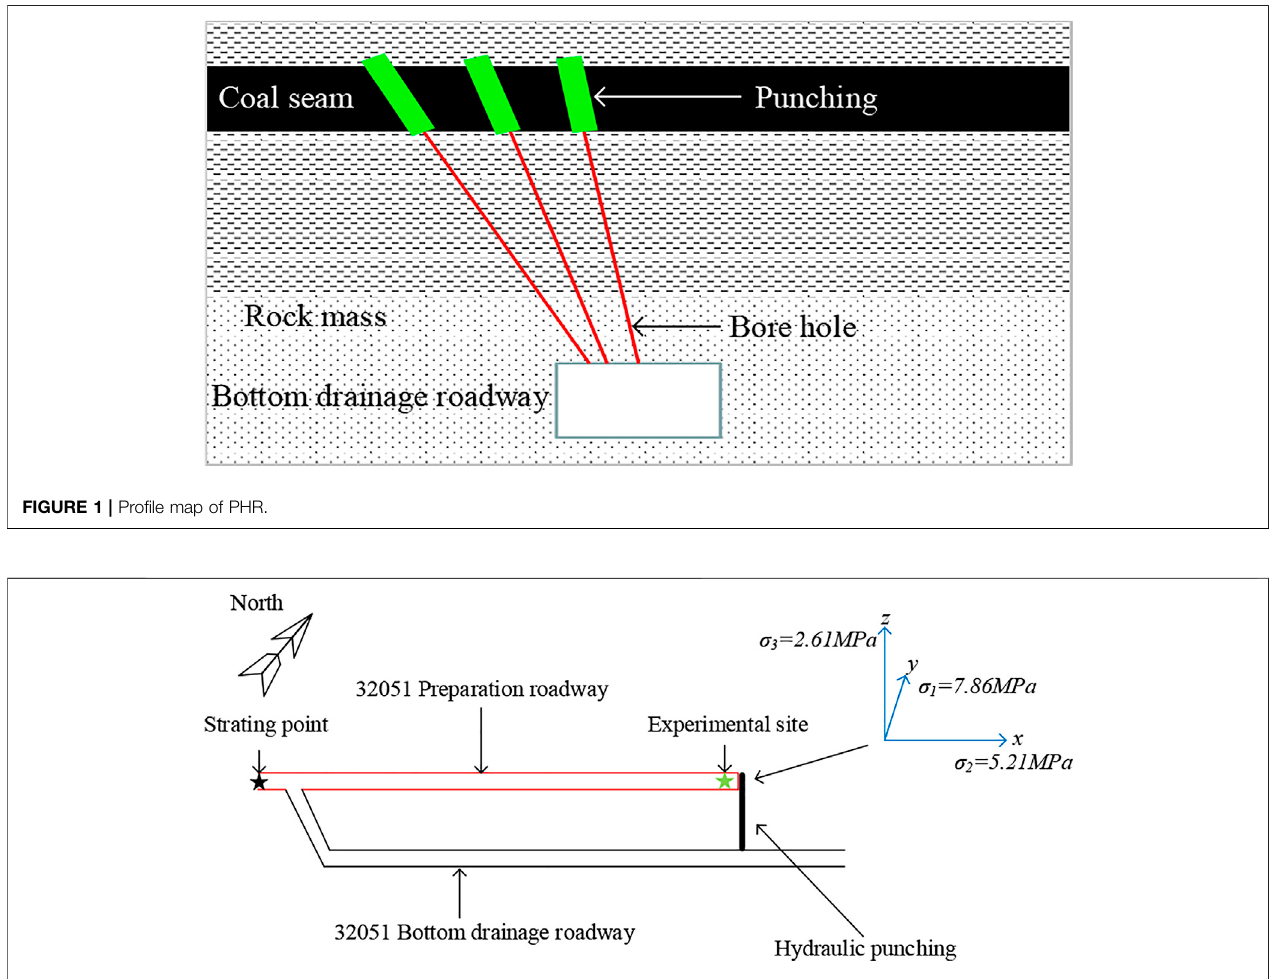
FIGURE 2 | Sketch map of experimental site and ground stress.